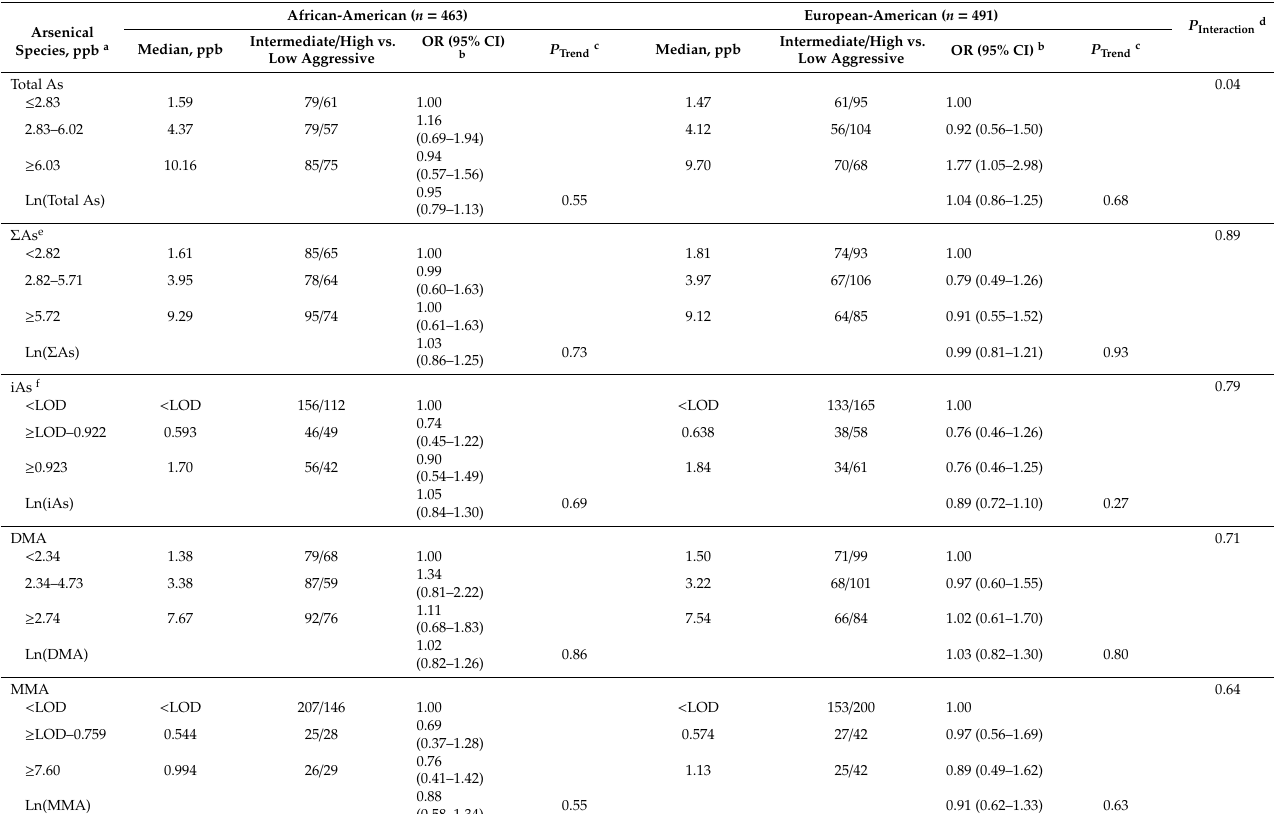
Table 3. Race-stratified odds ratios (ORs) and corresponding 95% confidence intervals (CIs) for the associations between quantiles of specific gravity-adjusted urinary arsenic concentrations and prostate cancer aggressiveness among PCaP men, ( n =